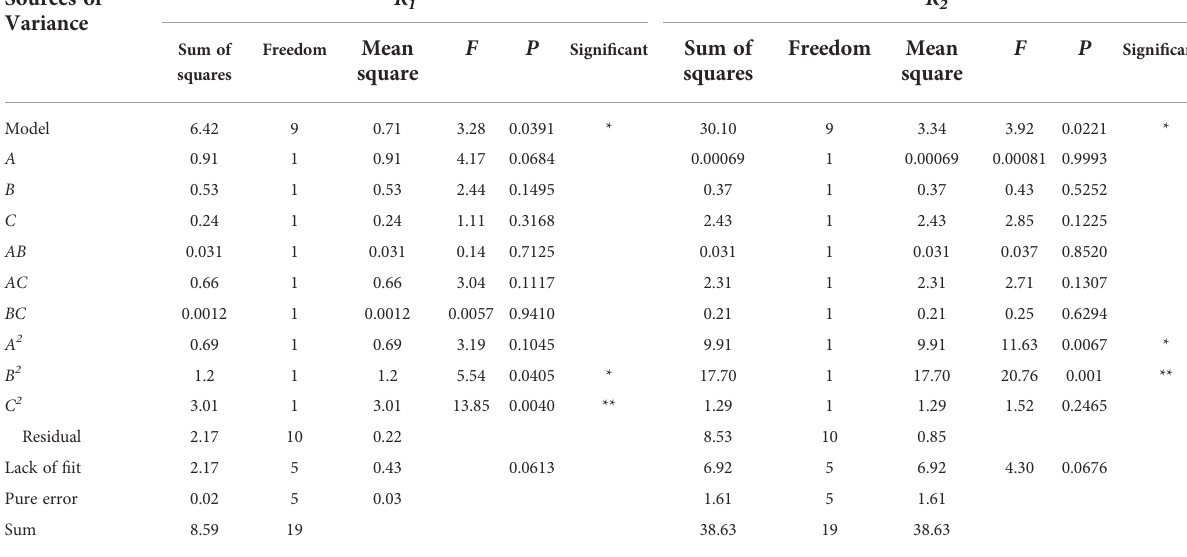
TABLE 4 Anova of response surface quadratic model for R 1 and R 2. .